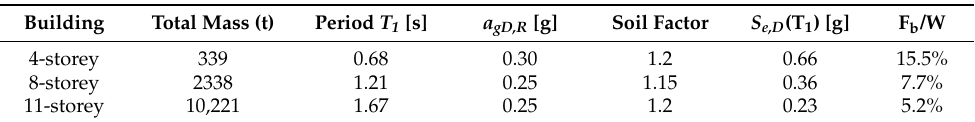
Figure 8. Elevations, plan views and reinforcement in typical columns and beams of ( a ) 4-, ( b ) 8- and ( c ) 11-storey buildings. Table 4. Total mass, first vibration period, reference peak ground acceleration, soil factor, spectral acceleration corresponding to first vibration mode from the elastic spectrum and design base shear– weight ratio of 4-, 8- and 11-storey